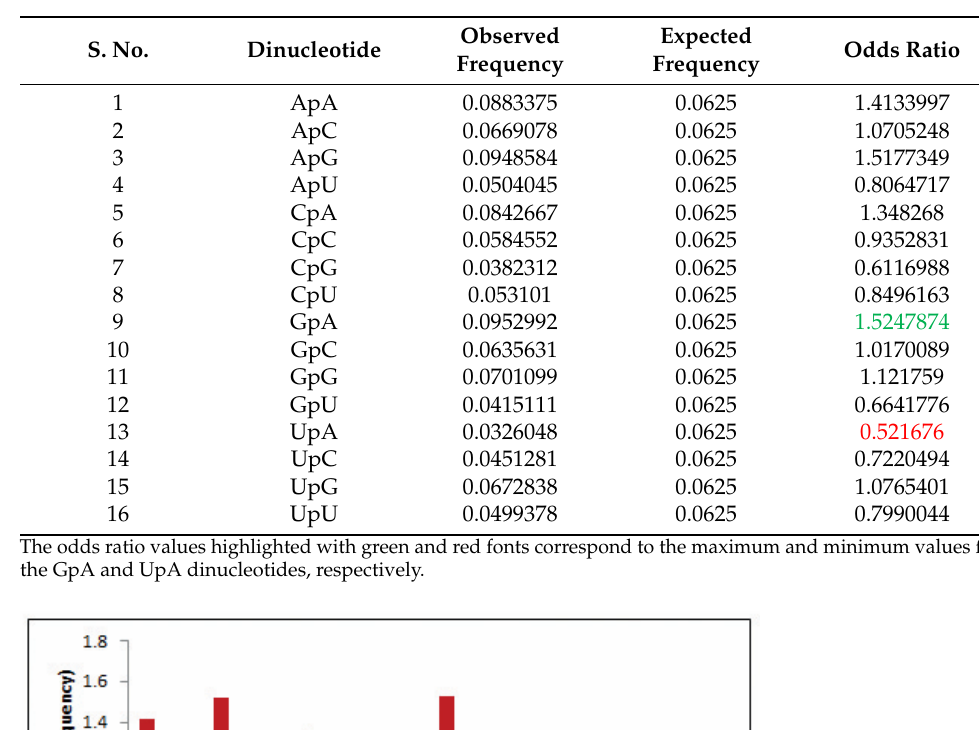
Table 3. The occurrence of the dinucleotide odds ratio in the EPB41L3 gene. The odds ratio was calculated by dividing each observed frequency by the expected frequency of dinucleotides.